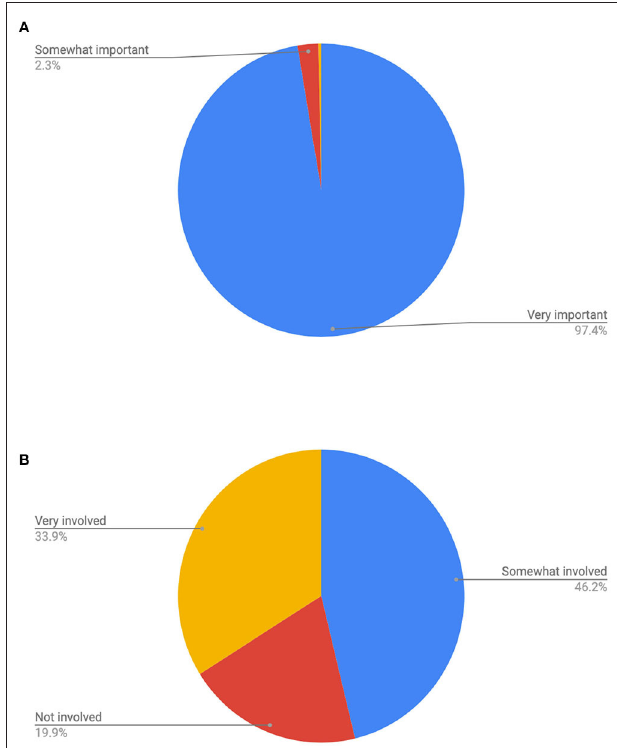
FIGURE 2 | (A) Count of how important is it to feel that you are included in making decisions regarding your care during labor? (B) Count of how much were you involved in making decisions regarding your care during labor.